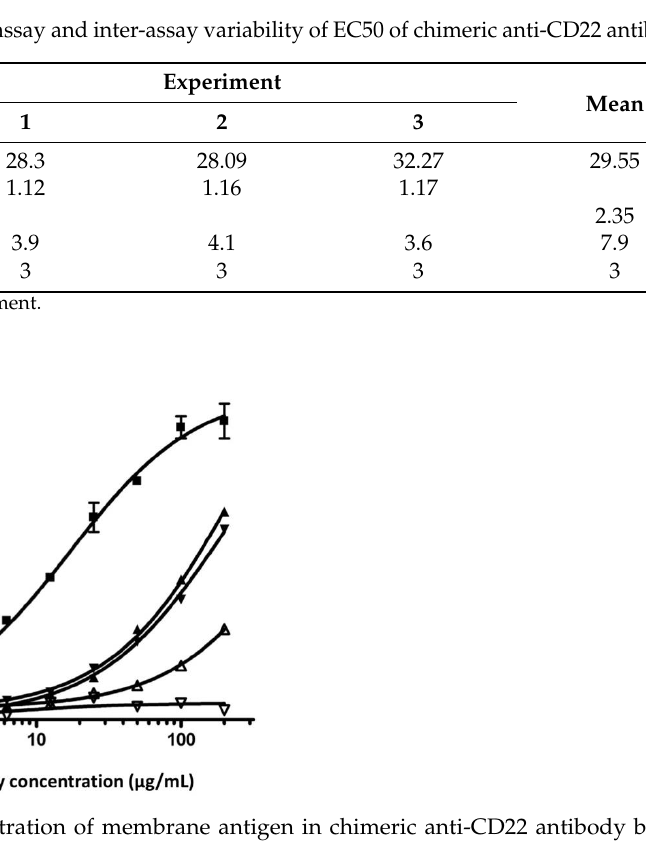
Figure 2. Effect of concentration of membrane antigen in chimeric anti-CD22 antibody binding assay. Membrane antigen was immobilized in a 96-well microplate at five different concentrations (1 μg/m L; 10 μg/m L; 0.1 mg/mL; 0.5 mg/mL; 1 mg/mL). Various concentrations of chimeric anti-CD22 antibody were used to detect membrane antigen. The averages of samples were plotted against the antibody concentration.